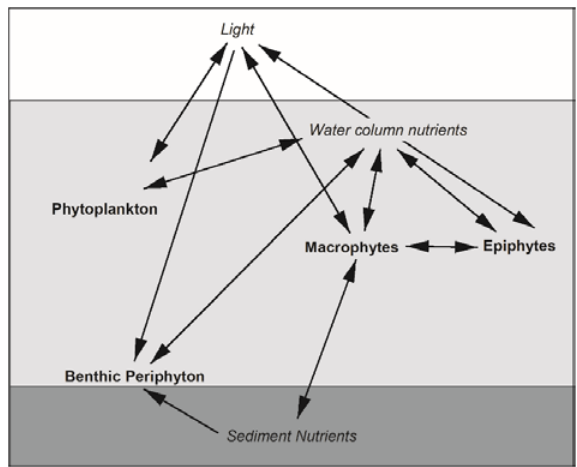
Figure 1. Interactions among littoral primary producers (bold) and their resources (italics) in lakes. Arrows represent the directions of interactions but do not differentiate between positive or negative effects.